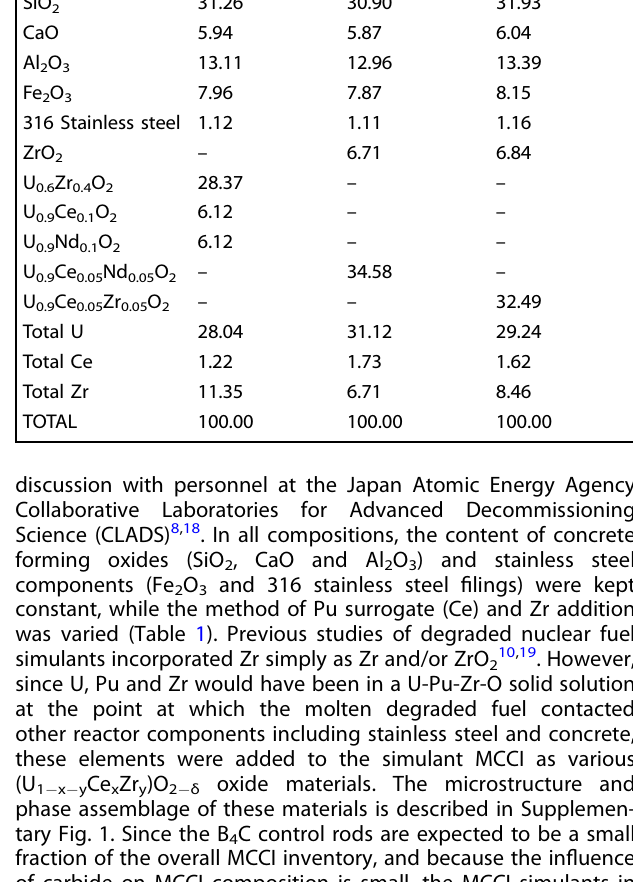
Table 1. As batched compositions of simulant MCCI materials. Component